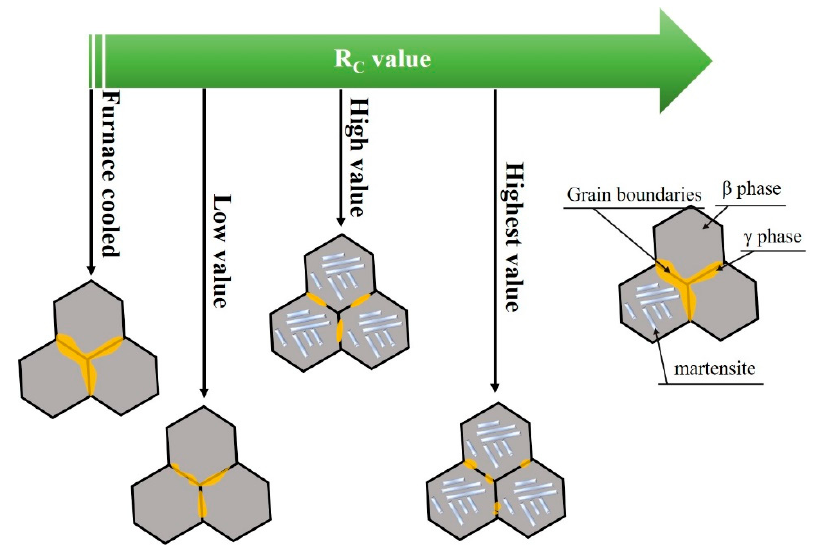
Figure 5. The schematic of the microstructural changes during the various RS processes.